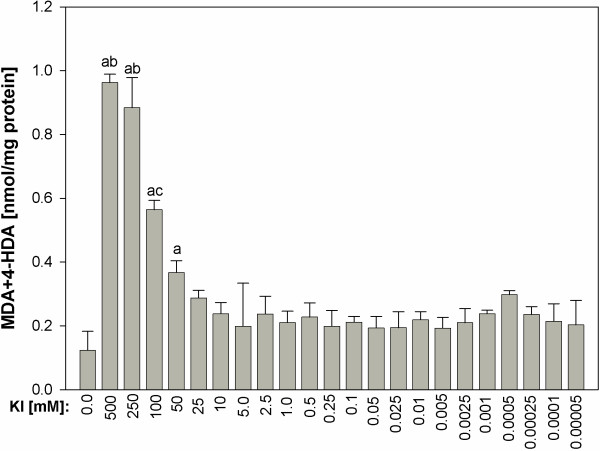
Lipid peroxidation, measured as MDA + 4-HDA level, in porcine thyroid homogenates. Homogenates were incubated in the presence of KI alone [500; 250; 100; 50; 25; 10; 5.0; 2.5; 1.0; 0.5; 0.25; 0.1; 0.05; 0.025; 0.01; 0.005; 0.0025; 0.001; 0.0005; 0.00025; 0.0001; 0.00005 mM]. Data are expressed as nmol/mg protein. Data are from four independent experiments. Values are expressed as mean ± SE (error bars). ap < 0.05 vs. control (in the absence of KI); bp < 0.05 vs. KI concentrations ≤100 mM; cp < 0.05 vs. any other KI concentration.